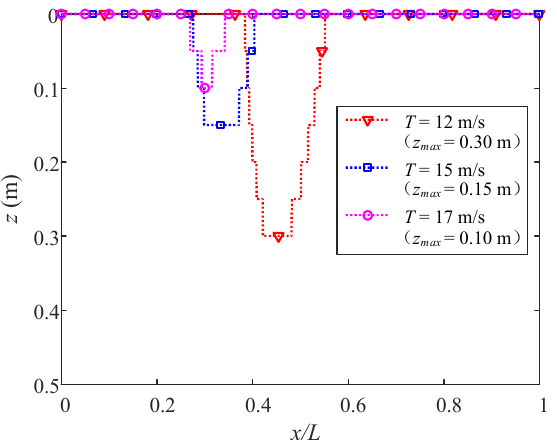
Figure 23. Distributions of maximum liquefaction depth with different wave periods.